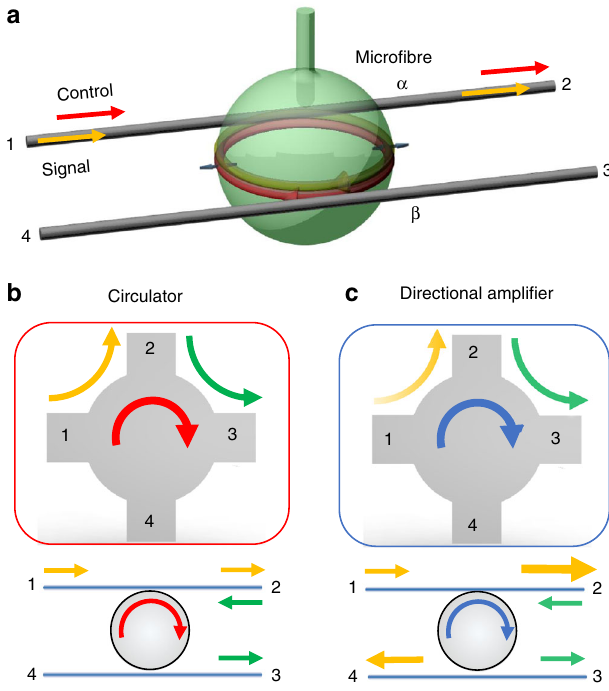
Fig. 1 Schematic of the optomechanical circulator and directional ampli fi er. a The device consists of an optomechanical resonator and two coupled micro fi bres. A control fi eld launched into port 1 excites the coupling between the mechanical motion and the clockwise (CW) optical fi eld. b , c Schematic of the circulator and directional ampli fi er, respectively. The routing direction of the signal light coincides with the control fi eld (that is, CW direction). For example, the signal entering port 1 is transmitted to the adjacent port 2 as indicated by the yellow arrows, while a signal input at port 2 will drop to port 3 as indicated by the green arrows. The port number follows that of the micro fi bres in a . For the directional ampli fi er, a larger arrow size indicates a gain in the corresponding direction, while the unchanged arrows represent the absence of